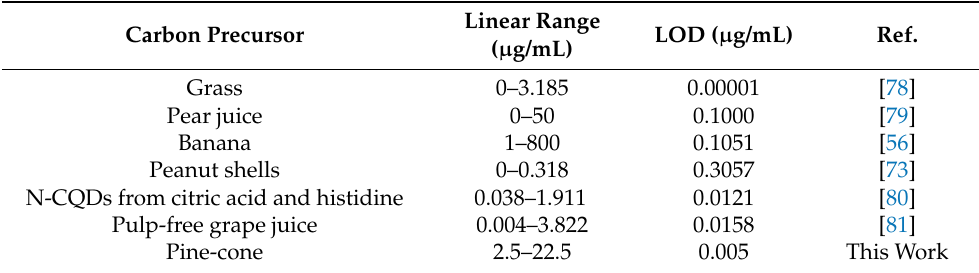
Figure 5. ( A ) FL emission spectra of synthesized PC-CDs upon addition of various concentrations of Cu 2+ ; ( B ) dependence of synthesized PC-CDs’ PL intensity on concentration of Cu 2+ ranging from 0 to 25 µ g/mL; and ( C ) Non- Linear response range plot of relationship between F 0 /F of synthesized PC-CDs and different Cu 2+ concentrations. Table 2. Comparison of different CDs from various carbon precursors with synthesized PC-CDs for the sensing of Cu 2+